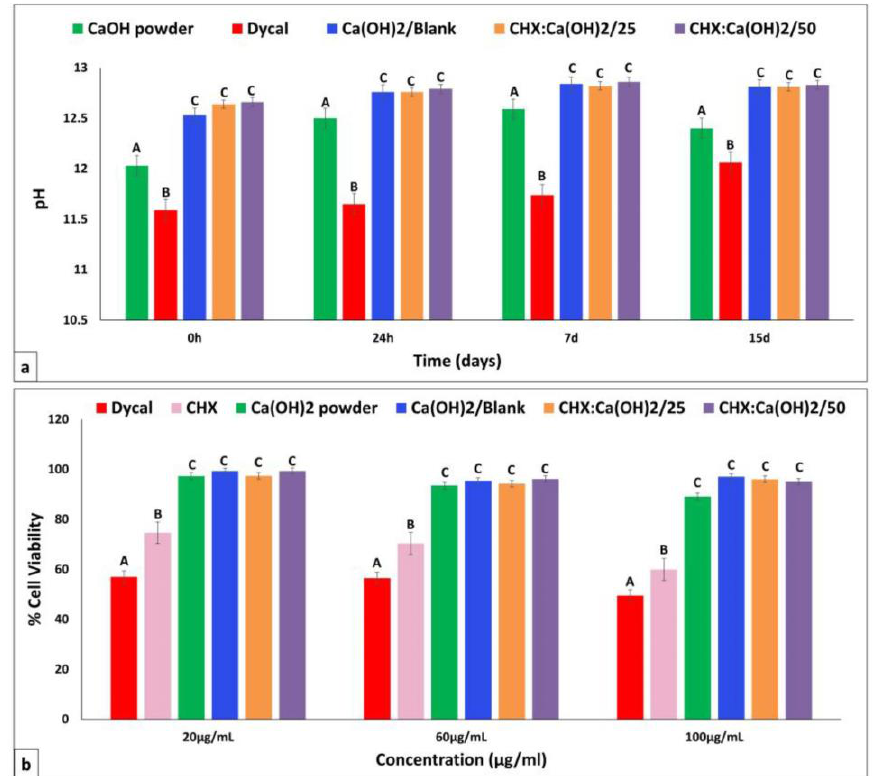
Figure 6. ( a ) Mean ± standard deviation of the measured pH values of the prepared Ca(OH) 2 /Blank microparticles, CHX-loaded/Ca(OH) 2 microparticles (at formulations of CHX:Ca(OH) 2 /25 mg and CHX:Ca(OH) 2 /50 mg), Dycal and the commercial Ca(OH) 2 powder determined at 0 h, 24 h, 7 days and 15 days respectively. The pH values of the prepared microparticles were consistently high ranging from ~12.5 to ~13.06 at all specified time points; whereas that of the commercial Ca(OH) 2 powder was comparatively lower ranging from ~12 to 12.5. No significant difference was observed between pH of the Ca(OH) 2 /Blank and the CHX-loaded/Ca(OH) 2 microparticles. Dycal demonstrated lowest pH with values ranging from ~11.59 to ~12.06. ( b ) Mean ± standard deviation of the percentage (%) cell viability of human mesenchymal stem cells (hMSCs) showing low cytotoxicity profile (>90%) upon 24 h of exposure to the different concentrations (20, 60 and 100 µ g/mL) of the Ca(OH) 2 /Blank microparticles, the CHX-loaded/Ca(OH) 2 microparticles, and the commercial Ca(OH) 2 powder. On the contrary, exposure to Dycal and pure CHX has reduced the viability of cells. * Groups with different alphabets are statistically significant ( p ≤ 0.05) within each time point and concentration for